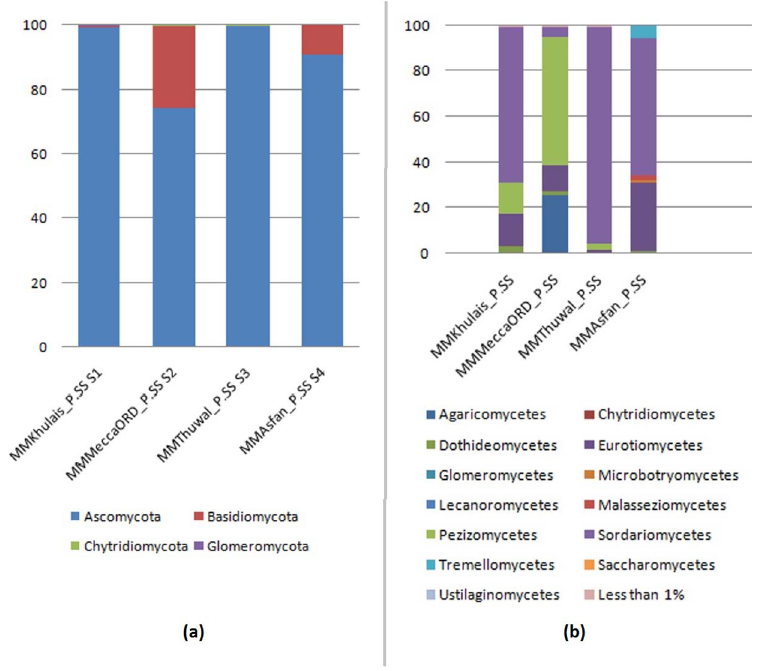
Fig 2. Read distribution of sequences according to phylum (a) and class (b) of fungi in the four sites.